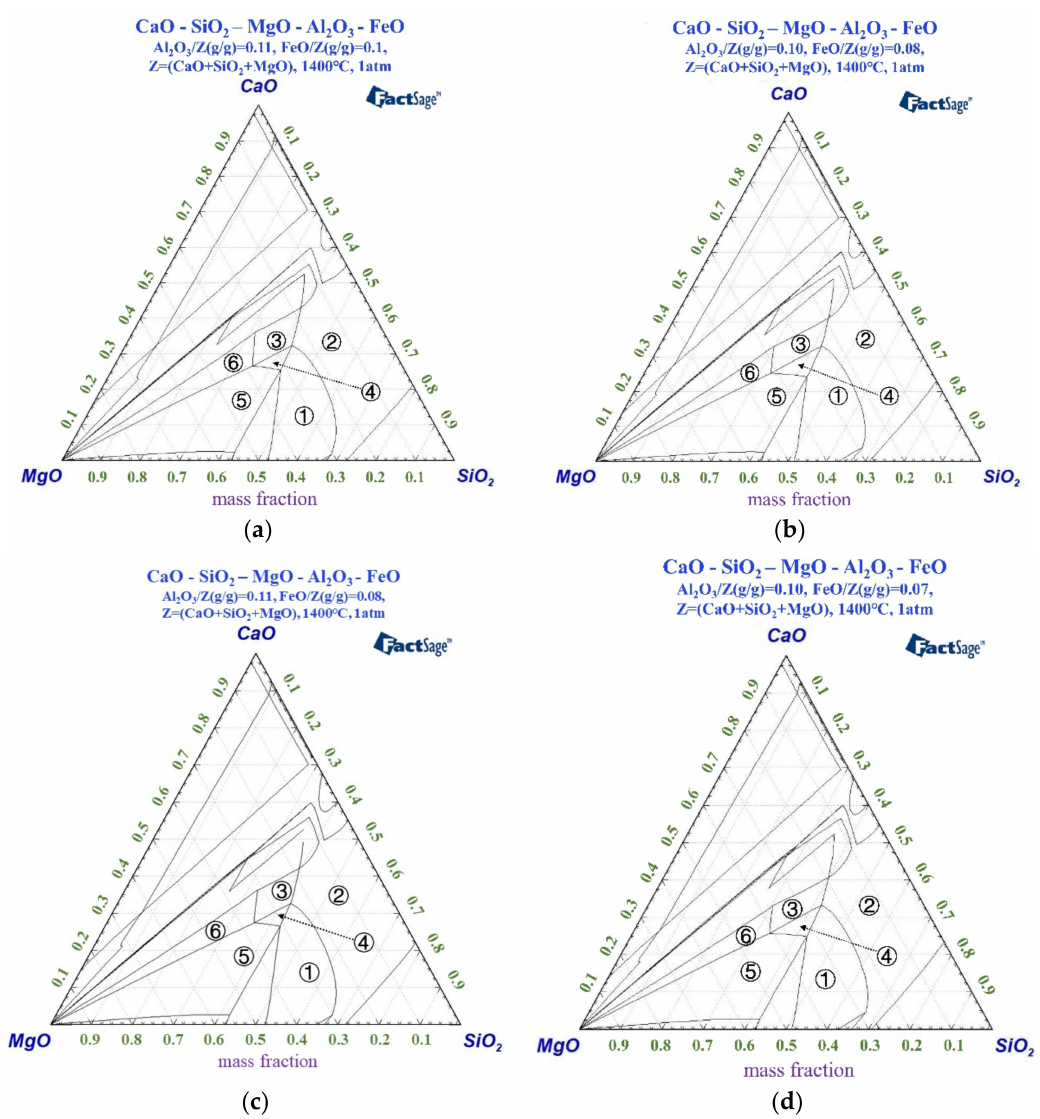
Figure 12. Quinary phase diagrams of slag at 1400 ◦ C. ( a ) H1 − A; ( b ) H1 − B; ( c ) H2 − A; ( d ) H2 −